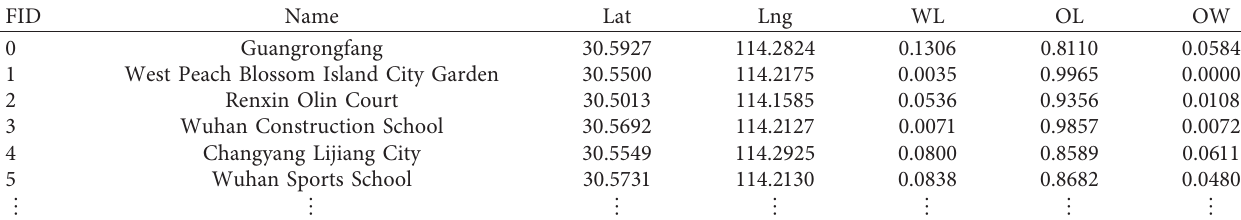
Figure 1: Case study area: (b) Wuhan, which is located in (a) Hubei Province. Table 1: The user data, including geographic location information and three different types of jobs-housing attribute populations. OW: only working, OL: only living, and WL: working and